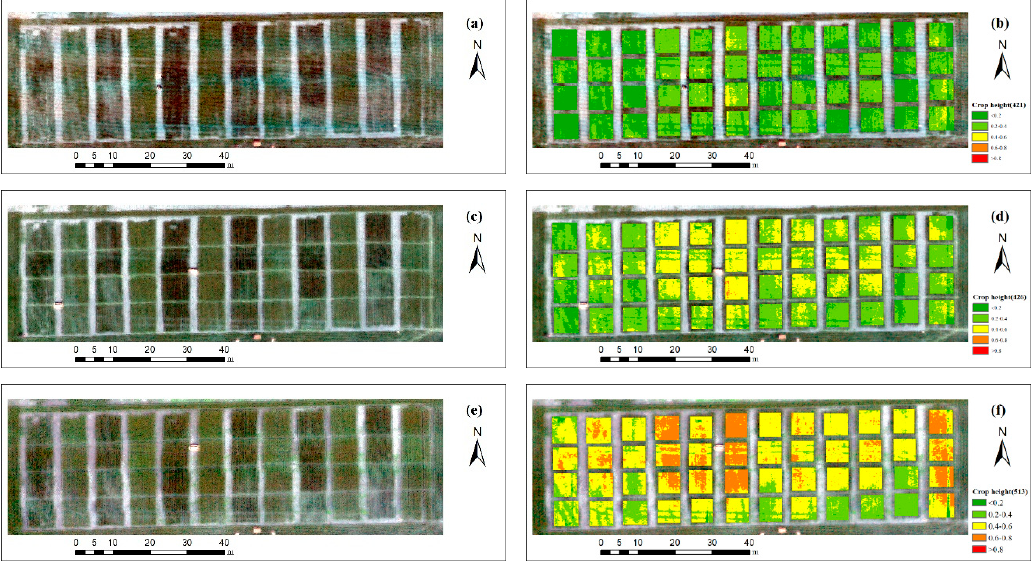
Figure 2. UAV-UHD hyperspectral images and corresponding crop height on ( a , b ) 21 April; ( c , d ) 26 April; and ( e , f ) 13 May 2015.